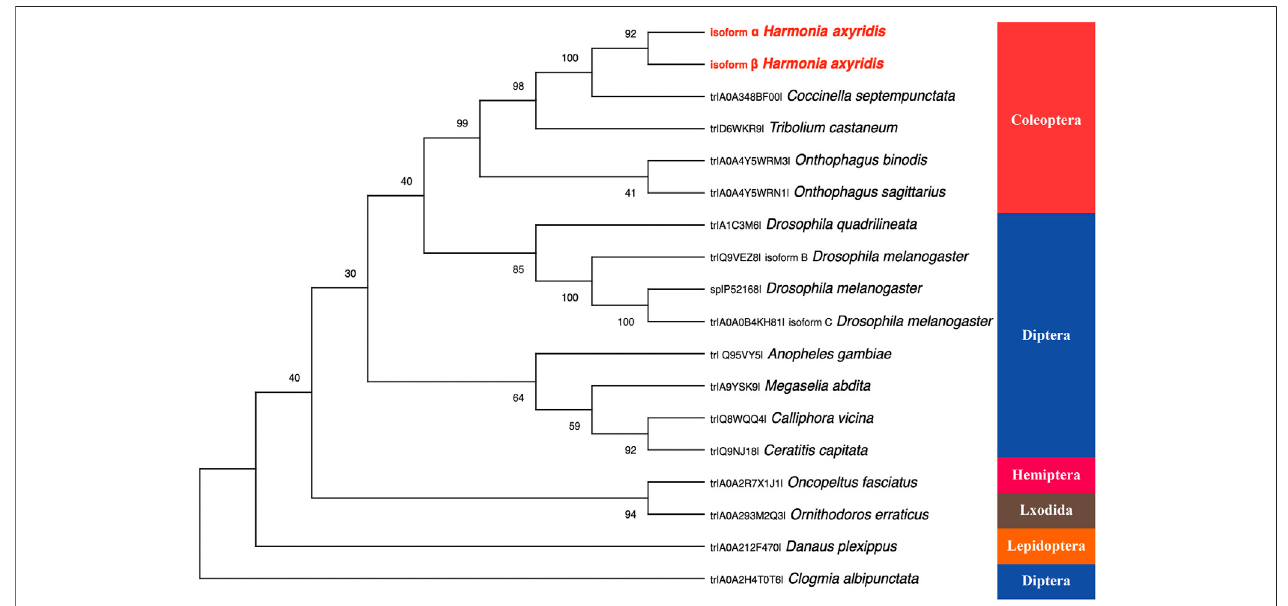
FIGURE 2 | The rooted phylogenetic tree of deduced Pannier coding sequences from 15 insect species as constructed by the neighbor-jointing method. All the names used in the tree consist of the UniProt entry number and species name.